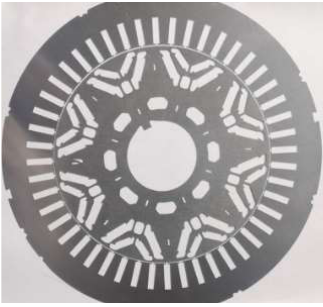
Figure 16. Electromagnetic structure of prototype motor. Table 9. Comparison of CLTC